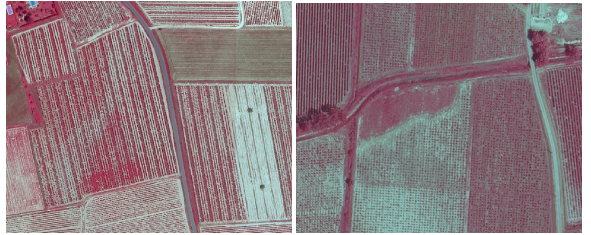
Figure 2: The appearance of vineyards